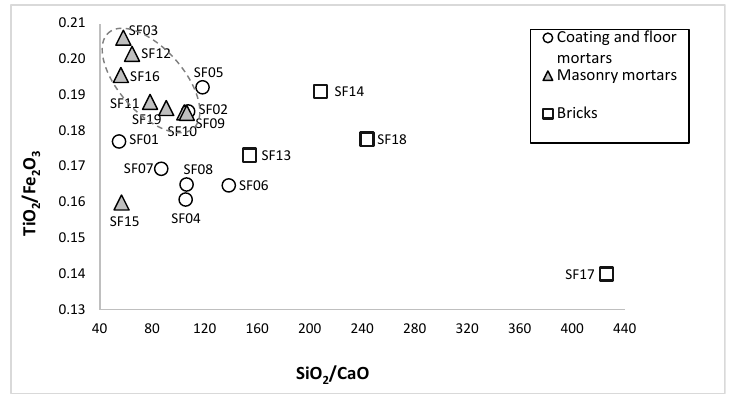
Figure 6. Mortars and bricks TiO 2 /Fe 2 O 3 vs. SiO 2 /CaO binary diagram.